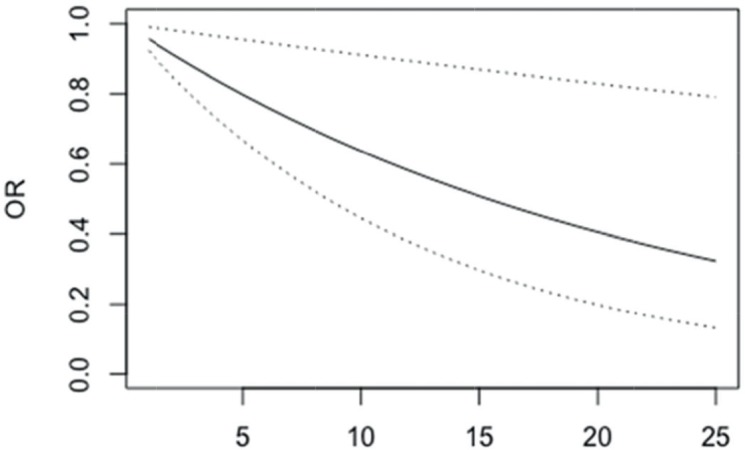
OR of not having depression in patients with differences in BRAS scale scores between 1 and 25 points (95% confidence bands for the OR are shown in dash lines).